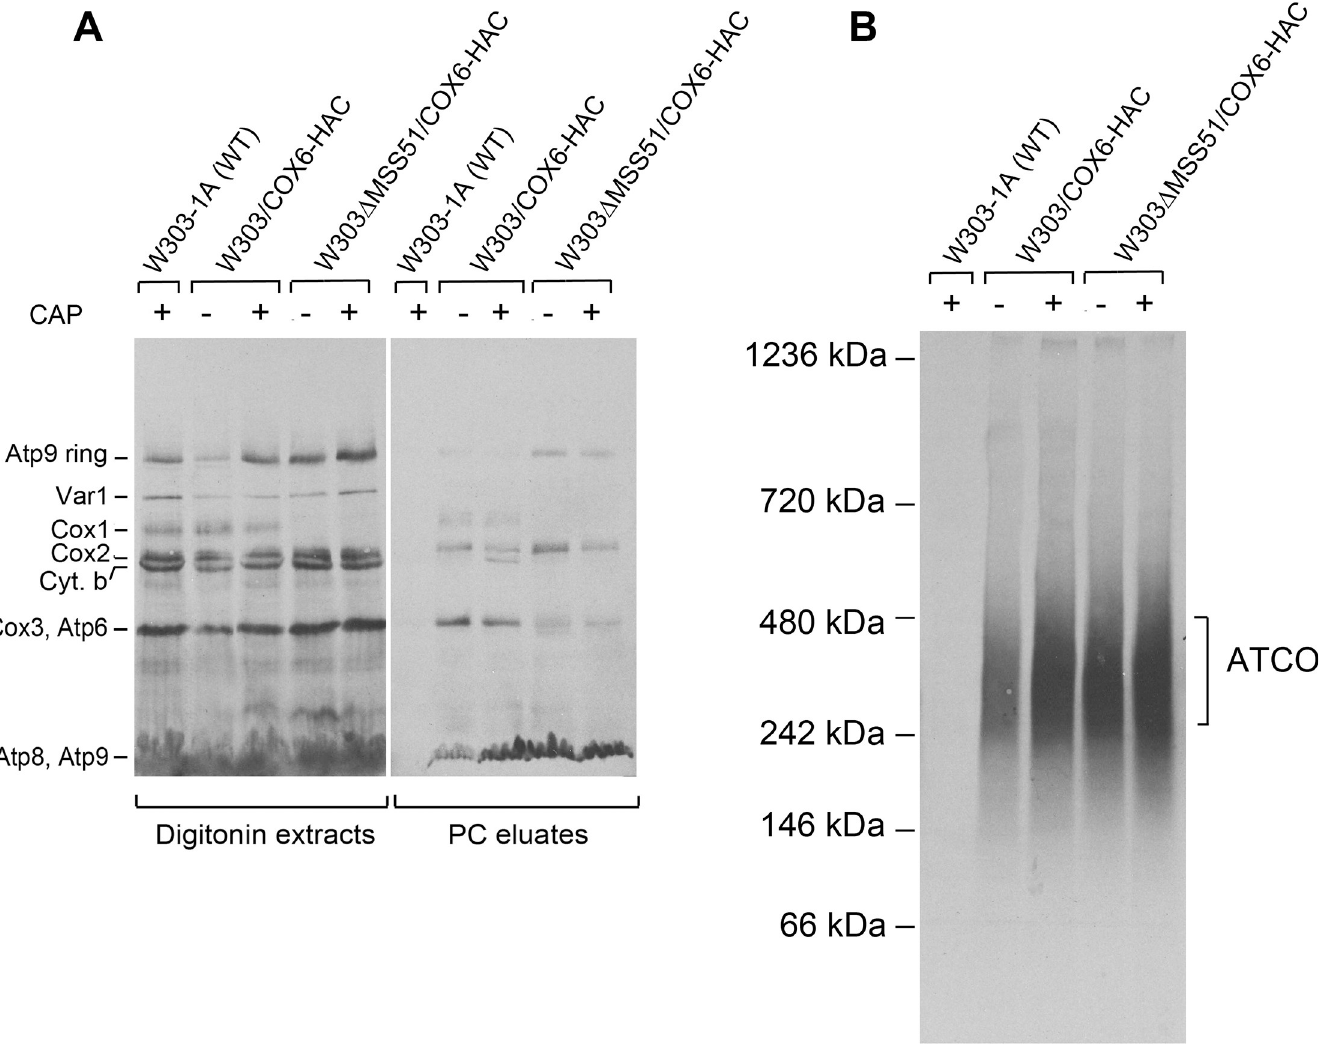
Fig 4. Effect of growth in chloramphenicol on Atco. Mitochondria were isolated from the parental strain W303-1B and from W303/COX6-HAC and W303 Δ MSS51/ COX6-HAC that had been grown to early stationary phase in rich galactose and grown for an additional 2 hours in fresh medium containing 2 mg/ml chloramphenicol. Mitochondria were also isolated from W303/COX6-HAC without and with the mss51 null mutation that had not been treated with chloramphenicol. Mitochondria were labeled with 35 S-methionine and cysteine for 20 min as described in the Materials and Methods section; they were extracted with digitonin at a final concentration of 2% and purified on protein C antibody beads. The digitonin extracts and purified fractions were separated by SDS-PAGE on a 12% polyacrylamide gel ( A ) and by BN-PAGE on a 4–13% polyacrylamide gel ( B ). Proteins were transferred to a PVDF membrane and exposed to X-ray film. The radiolabeled mitochondrial gene products are identified in the